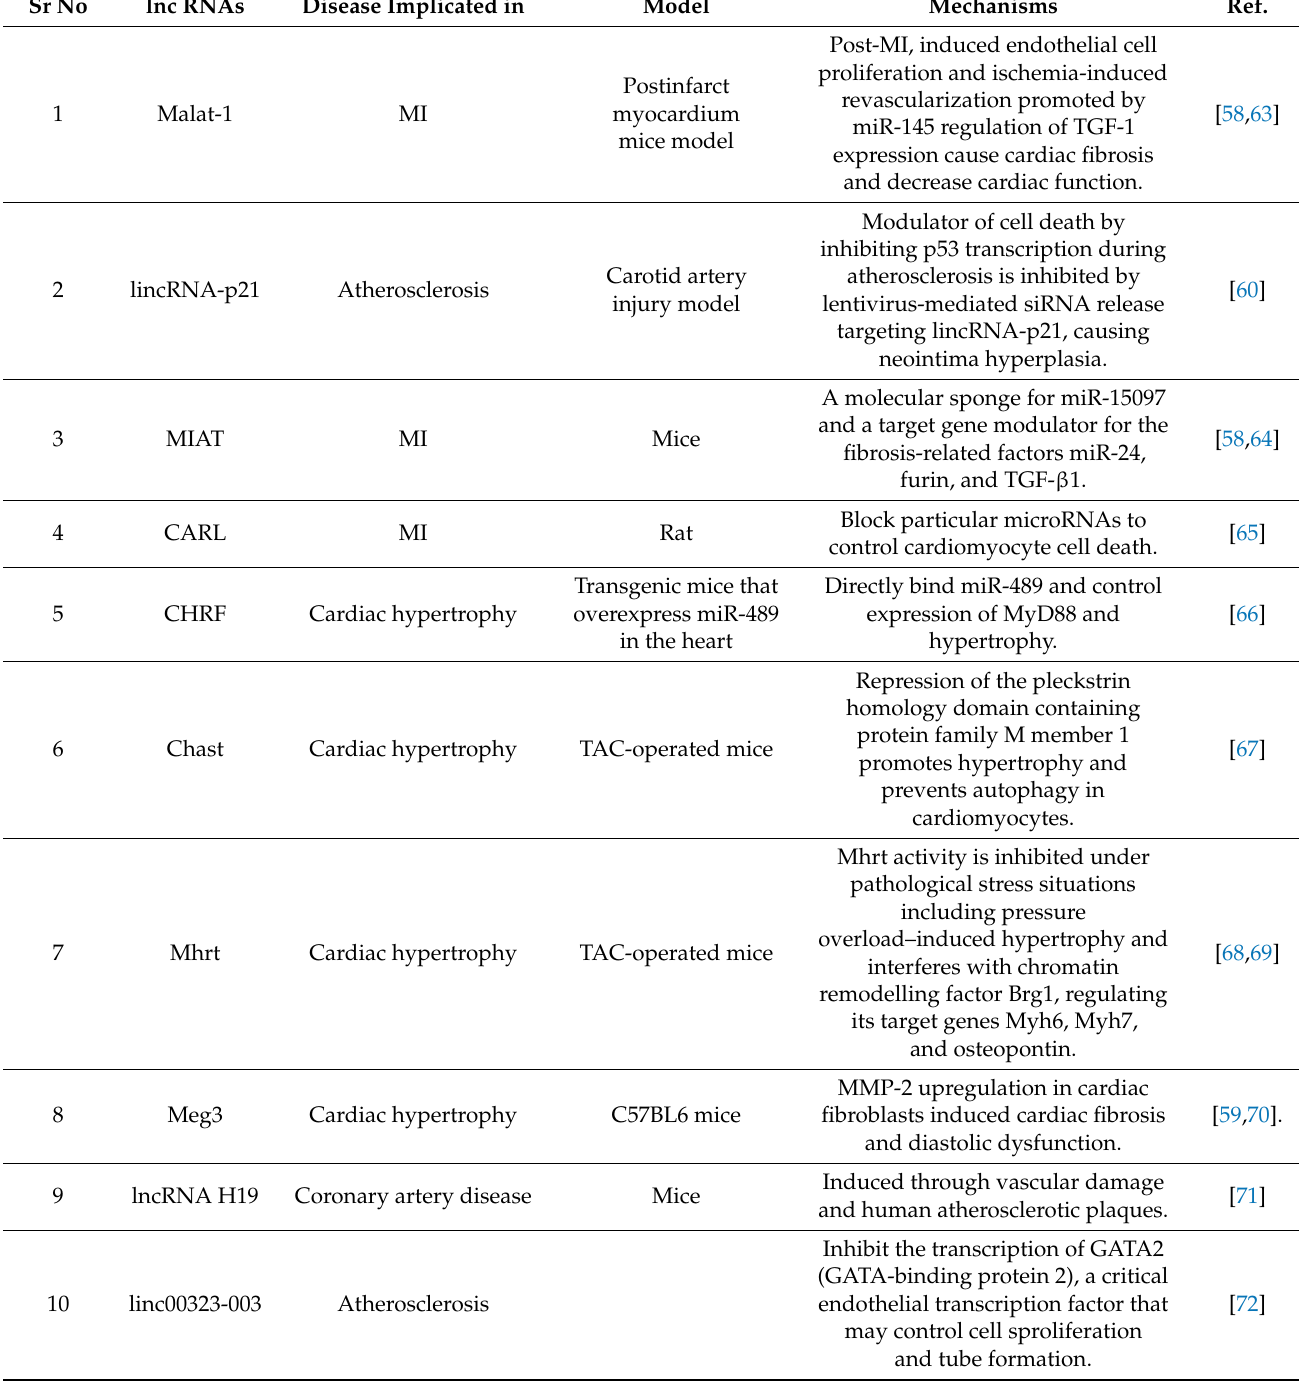
Table 2. Long non-coding